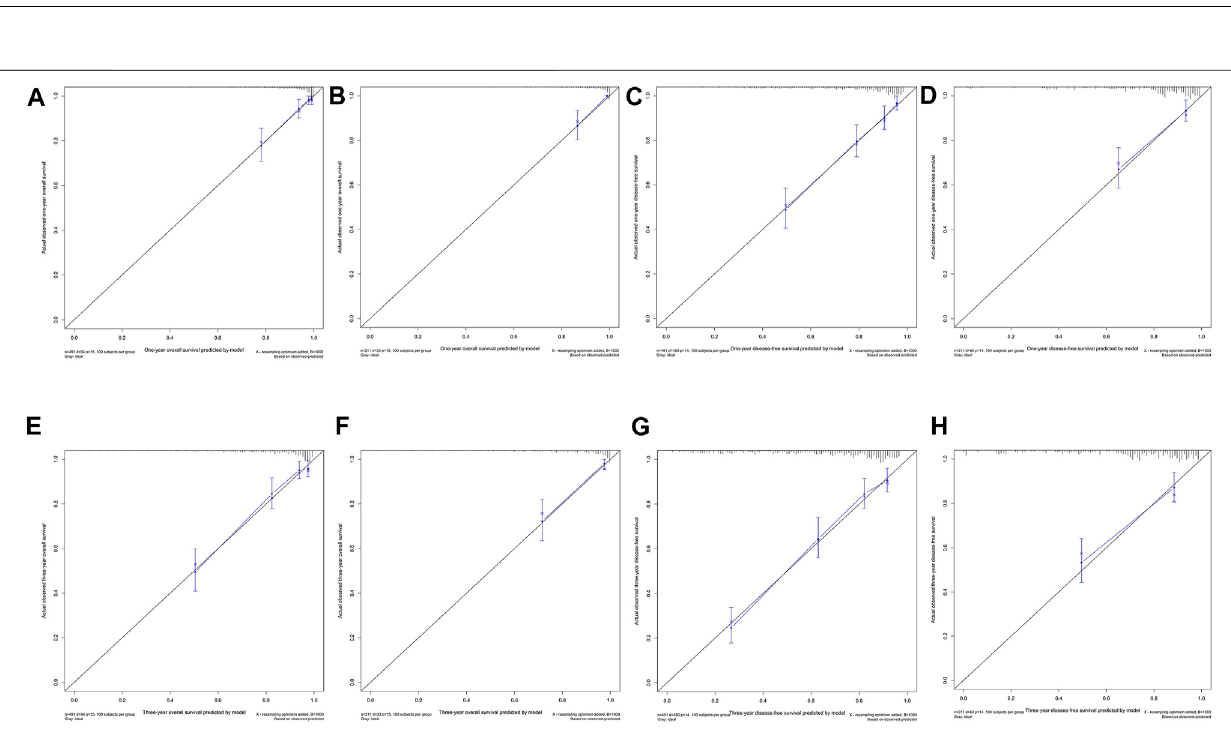
Frontiers in Molecular Biosciences |